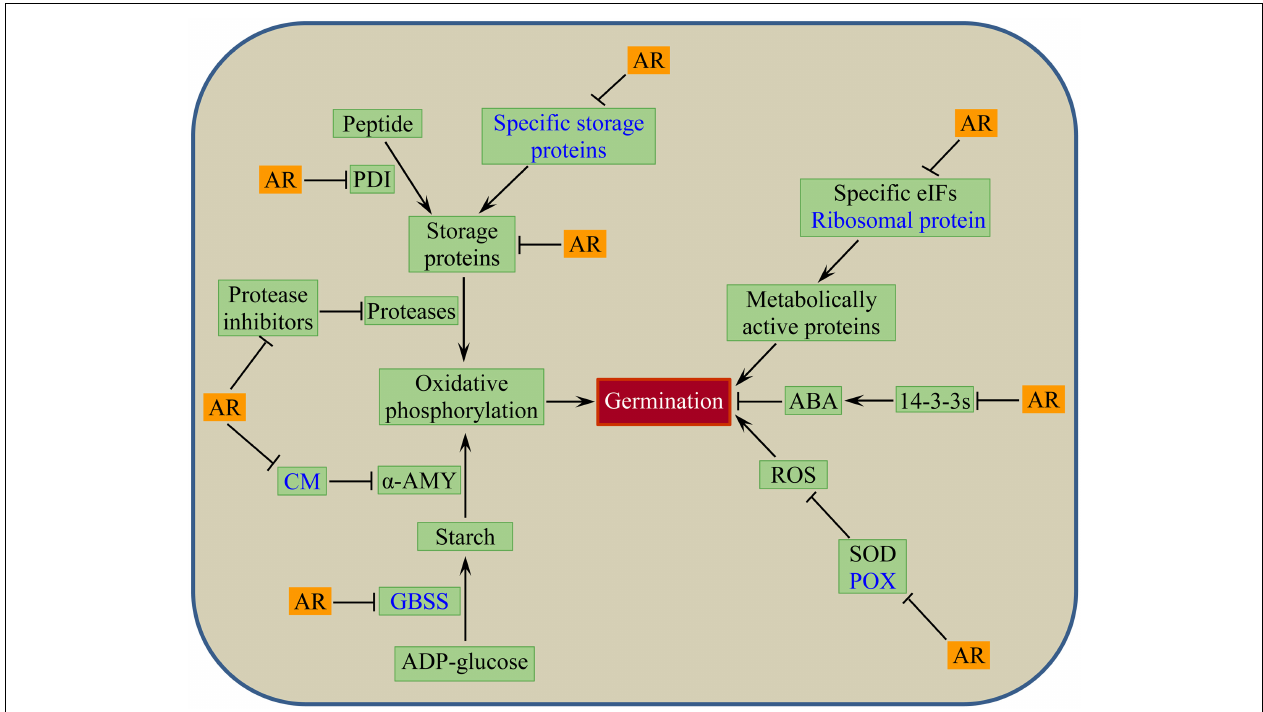
after-ripening; PDI, protein disulfide isomerase; CM, chloroform: methanol soluble α -amylase/trypsin inhibitor; α -AMY, alpha-amylase; GBSS, granule bound starch synthase; eIFs, eukaryotic translation initiation factors; 14-3-3s, 14-3-3 proteins; ABA, abscisic acid; SOD, superoxide dismutase; POX, peroxidase; ROS, reactive oxygen